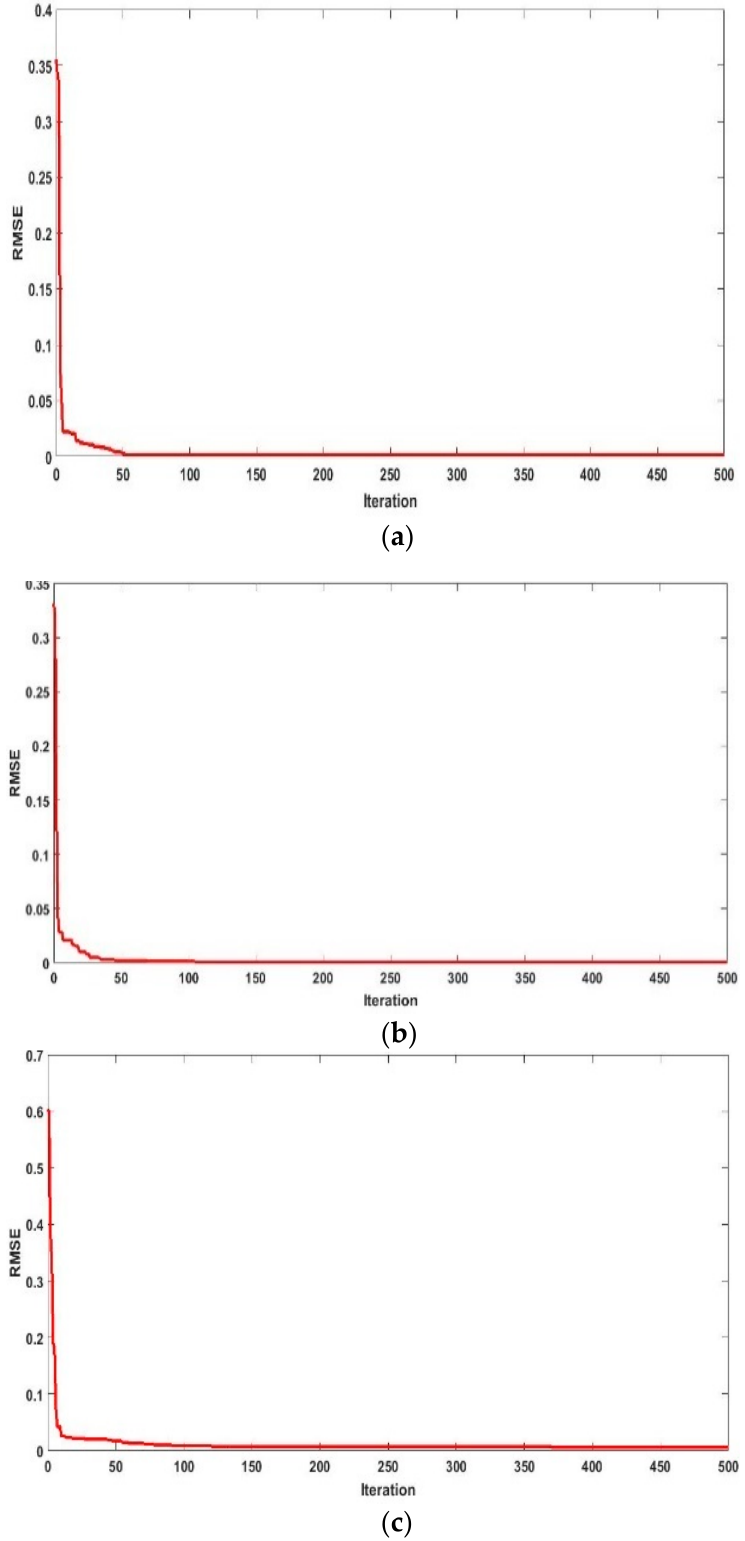
Figure 9. Convergence rates at different environmental impacts using EHO for MDDM; ( a ) at 109.2 W/m 2 and 310.32 K, ( b ) at 246.65 W/m 2 and 313.32 K, and ( c ) at 347.8 W/m 2 and 316.95 K.